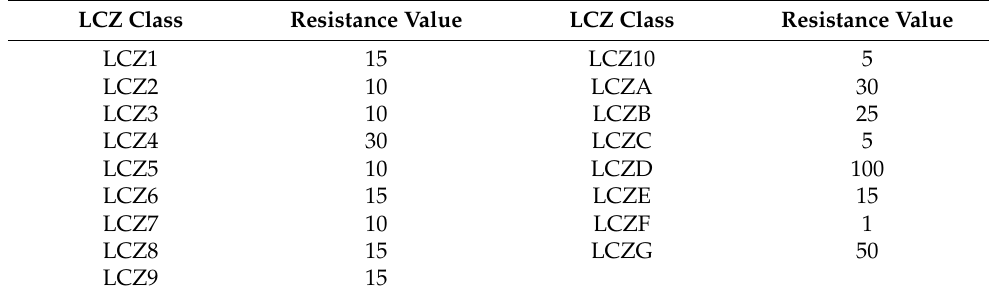
Table 8. LCZ-based resistance values for cold island